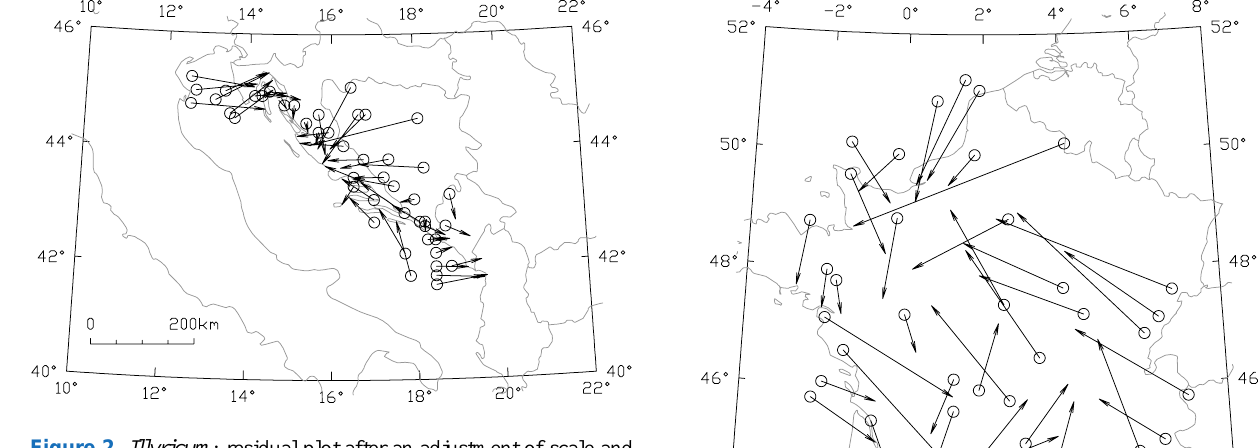
Figure 2. Illyricum : residual plot after an adjustment of scale and shift ( point : (¯ λ, ¯ φ ), arrowhead : ( λ,φ )).